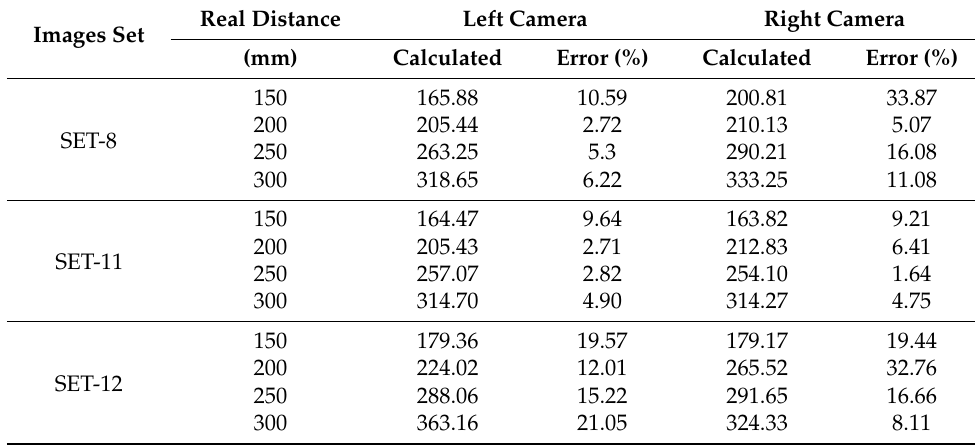
Table 1. Experimental distance evaluation based on low-cost cameras’ vision.